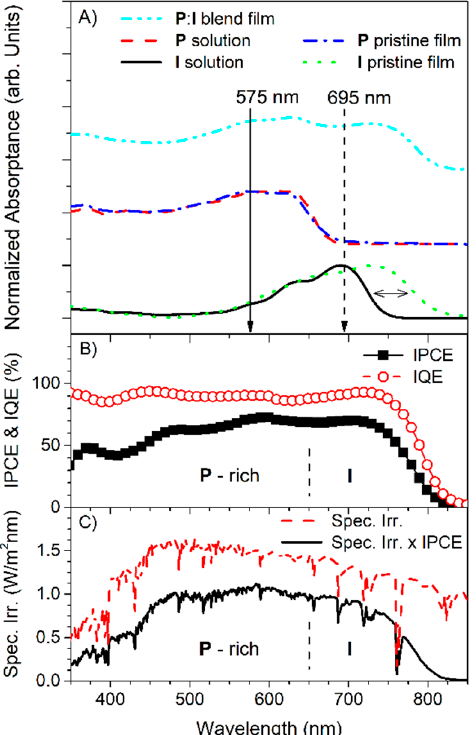
Figure 1. ( A ) Absorptance spectra of a P : I blend film, P pristine film, I pristine film, P solution, and I solution. Arrows mark the excitation wavelengths of 575 nm (solid line) and 695 nm (dashed line). The percentage absorptance is plotted rather than the logarithmic absorbance to enable direct comparison of the IPCE and IQE spectra; ( B ) IPCE spectrum (rectangular markers) and corresponding IQE spectrum (circular markers) of the P : I blend film; ( C ) Spectral irradiance (Spec. Irr.) spectrum (dashed line) of the global tilt solar radiation under the air mass 1.5 condition [29] and its weighted spectrum (solid line) are multiplied by the IPCE spectrum of ( B